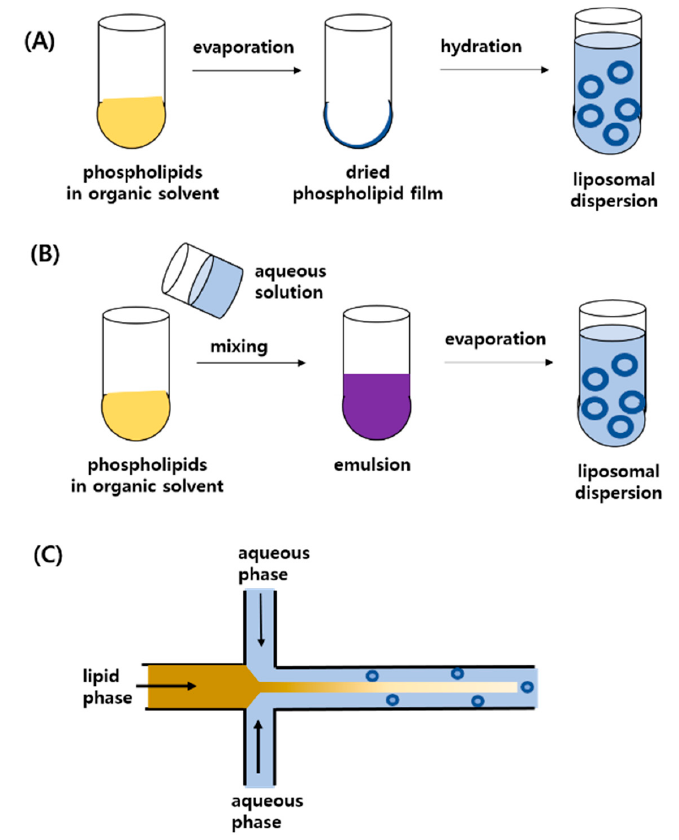
Figure 4. Representative techniques for the preparation of liposomes: film hydration method ( A ), reverse phase evaporation method ( B ) and microfluidic method ( C ) .